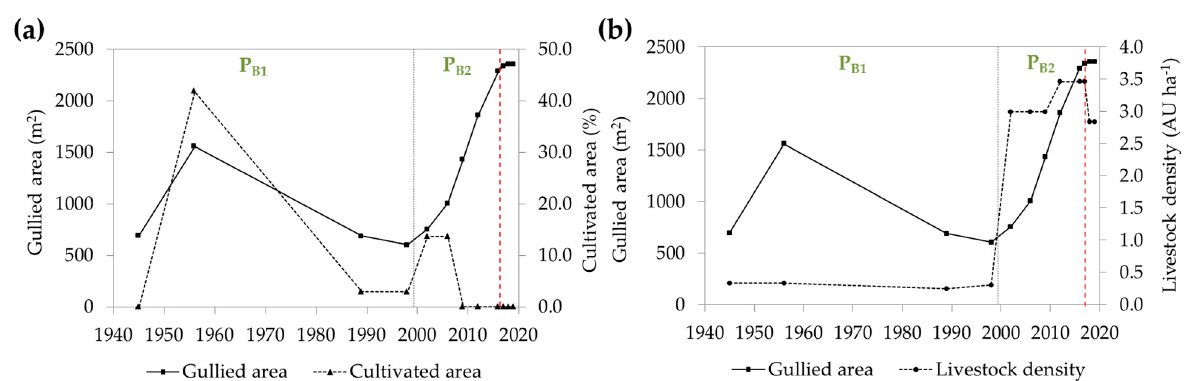
Figure 7. Evolution of the gullied area (m 2 ): ( a ) the cultivated area and ( b ) the livestock density (AU ha − 1 ). The vertical red line indicates the date of the restoration activities. Data from 1945 to 2006, taken from Gómez-Gutiérrez et al. [11].